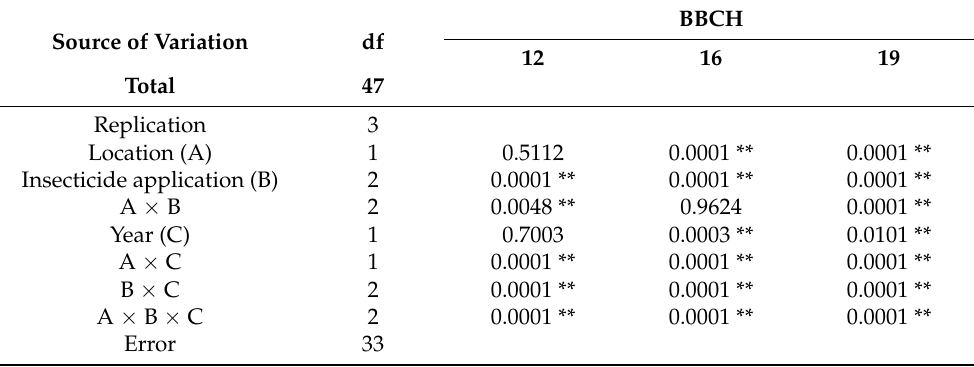
Table 4. Factorial analysis (ANOVA) of the percent of damages (according to Towsend-Heuberger) caused by sugar beet flea beetle in different developmental stages of sugar beet plants. Source of Variation df